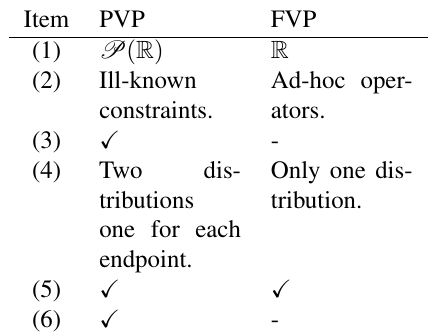
Table 1. Comparative PVP vs